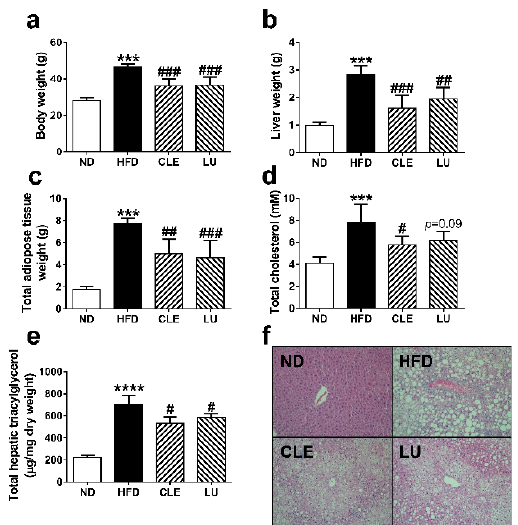
Figure 2. Effect of Chrysanthemum morifolium Ramat leaf extracts (CLE; 1.5%) and luteolin (LU; 0.003%) on body weight ( a ), liver weight ( b ), total adipose tissue weight ( c ), total cholesterol level ( d ), total hepatic triacylglycerol contents ( e ), and hepatic morphology (original magnification × 100) ( f ) in C57BL/6J mice fed a high-fat diet (HFD). The data are shown as mean ± standard deviation (SD) ( n = 6). *, # different letters indicate significant difference compared with normal diet (ND) group (*) and HFD group (#), as determined by Tukey’s multiple comparisons test. (*** p < 0.001, **** p < 0.0001, # p < 0.05, ## p < 0.01, ### p < 0.001).